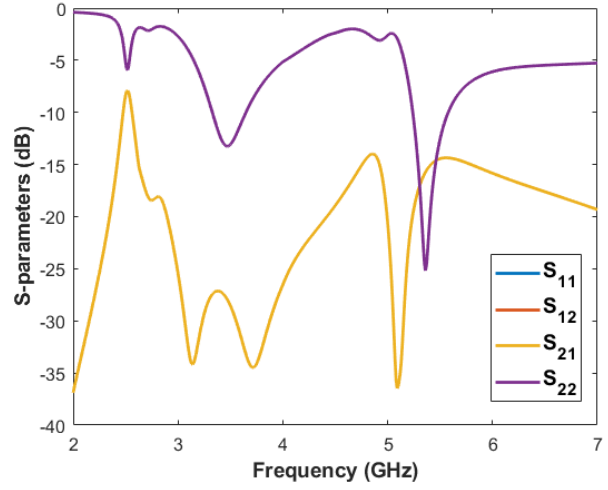
( c ) Figure 10. The proposed dual-band MIMO antenna configuration: ( a ) side view, ( b ) top view, and ( c ) bottom view. The design procedure is very similar to that presented in Section 2. Such as in the first design, the surface current densities are analyzed, and to develop the parasitic element used to reduce the mutual coupling between the two ports, the equations (1) and (2) are used. Considering (1) and (2) and central frequencies of 3.5 and 5.35 GHz, the L-shaped stubs lengths for the new design are 26.08 mm and 16.91 mm, respectively. The values of 𝐿 (cid:3051) , 𝐿 (cid:3052) , and 𝑊 (cid:3046)(cid:3047) are optimized and defined as 25 mm, 3.1 mm, and 1 mm, respectively, for 3.5 GHz, and 15 mm, 2.6 mm, and 0.5 mm, respectively, for 5.35 GHz. 3.1. Antenna Performance The simulated S-parameters of the proposed dual-band MIMO antenna after optimi-